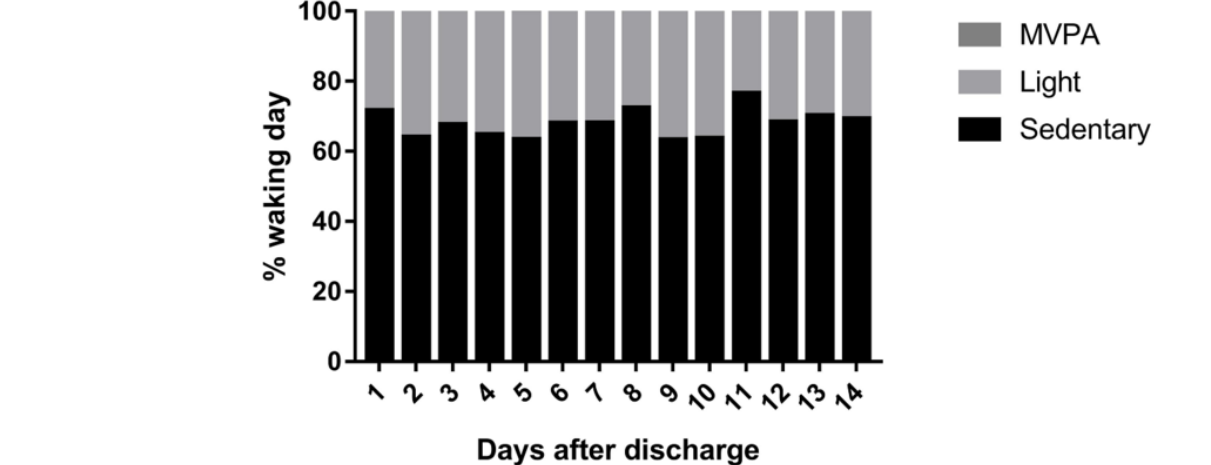
Figure 5. Proportion of each waking day spent being stationary, in light activity and in moderate to vigorous physical activity (MVPA) during the 14-day study period for patients with ≥ 4 valid days for each of the 2 weeks. N=8 for day 7 and day 8; N=7 for day 2, day 3, day 4, day 9, day 12, and day 13; N=6 for day 1, day 5, day 6 and day 11; and N=5 for day